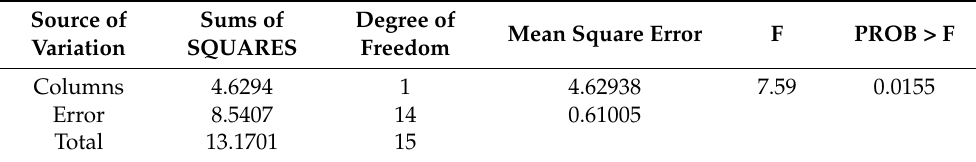
Figure 8. ANOVA comparison of error in groups GP and FNN models. Table 7. ANOVA analysis of error metrics MAE, MSE, SEE and MAPE between GP and FNN models for PROB > F( value P for testing null hypotesis).